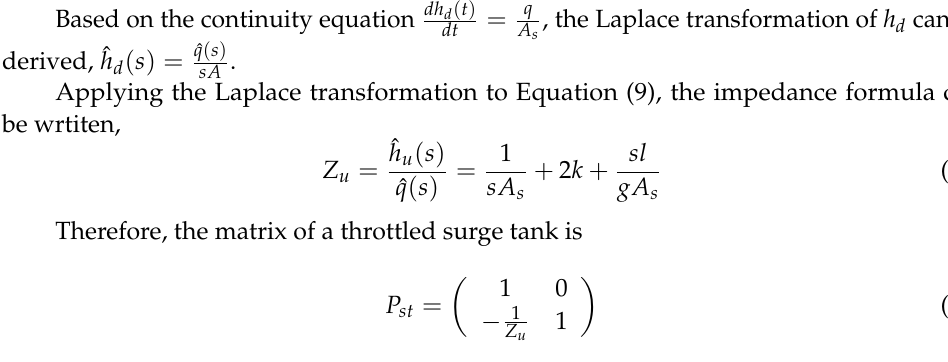
Figure 4. Sketch of the throttled surge tank.